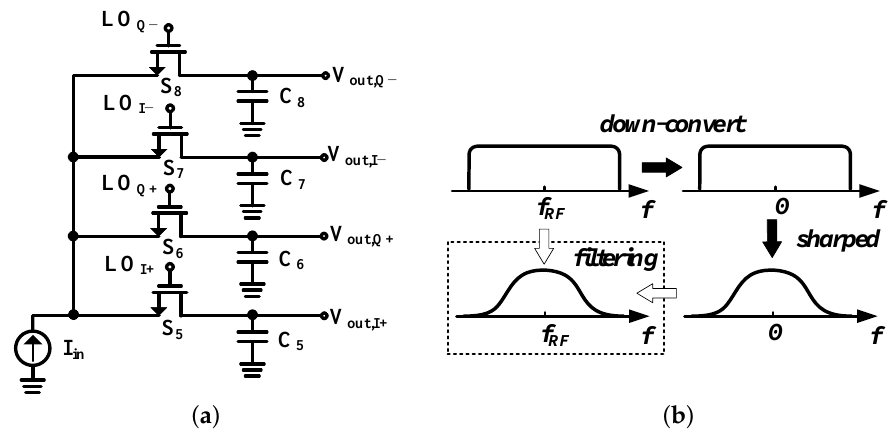
Figure 6. ( a ) Schematic of the NPSC mixer. ( b ) Spectra of the NPSC mixer at input and output.